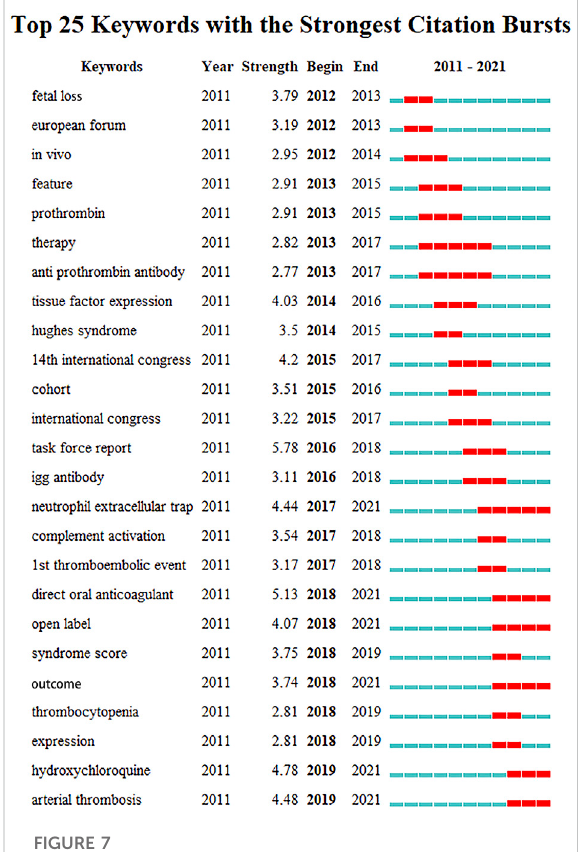
FIGURE 7 Top 25 keywords with the strongest citation bursts by CiteSpace. Each rectangle represents a year. Green rectangles indicate the time interval, and red rectangles indicate the duration of the burst from the beginning to the